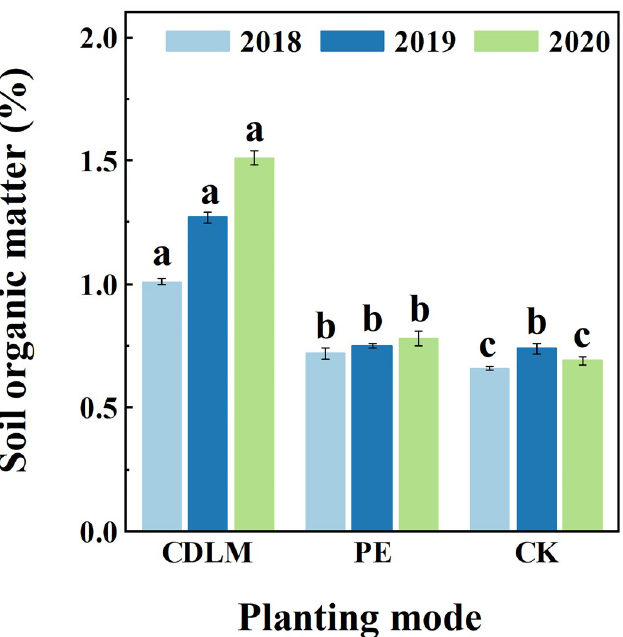
Fig 7. The contents of soil organic matters under CDLM, PE films and CK after the harvest in 2018, 2019 and 2020. Different superscripted letters (a, b, and c) indicate significant differences between the treatments in each year (p < 0.05).